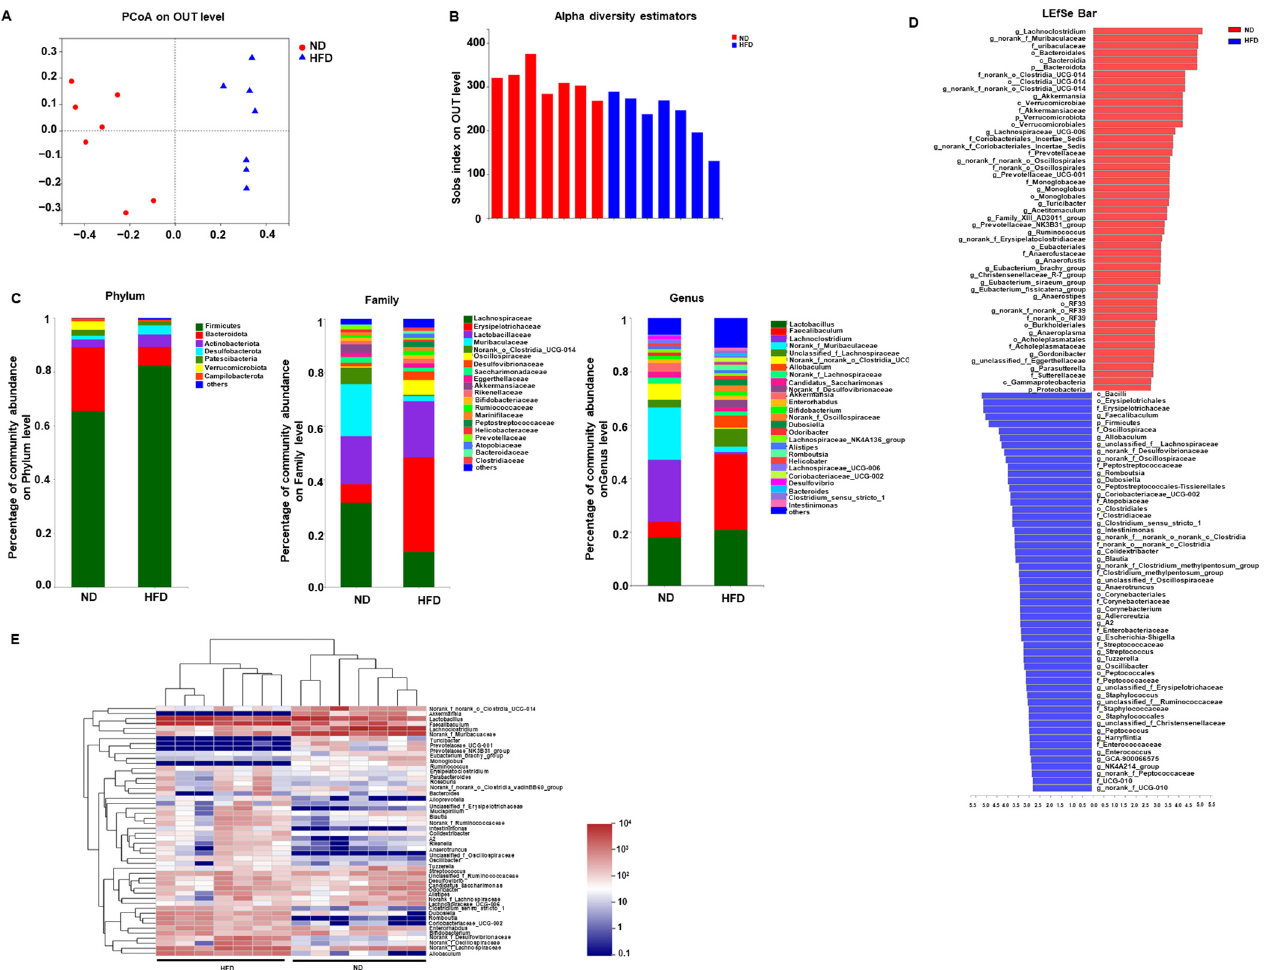
Figure 5. Effect of long-term HFD consumption on gut microbiota in mice. Principal coordinates analysis plot of unweighted UniFrac distances ( A ), Alpha diversity in ND- and HFD- fed mice using Sobs index on OUT level ( B ), Community alterations at Phylum, Family, and Genus level ( C ), Linear discriminant analysis (LDA) effect size showing the most differentially significant abundant taxa ( D ), Community heatmap analysis on Genus level in mice ( E ).